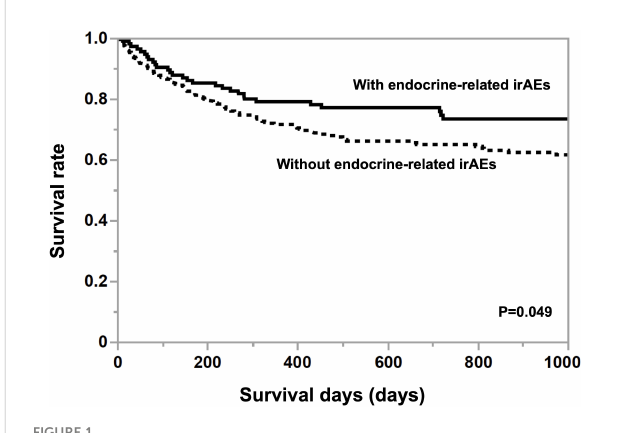
FIGURE 1 Kaplan-Meier curves in participants grouped by the presence or absence of endocrine-related irAE. A log-rank test was used for analysis, and survival was signi fi cantly greater (p<0.05) in participants with endocrine-related irAEs compared to those without endocrine- related